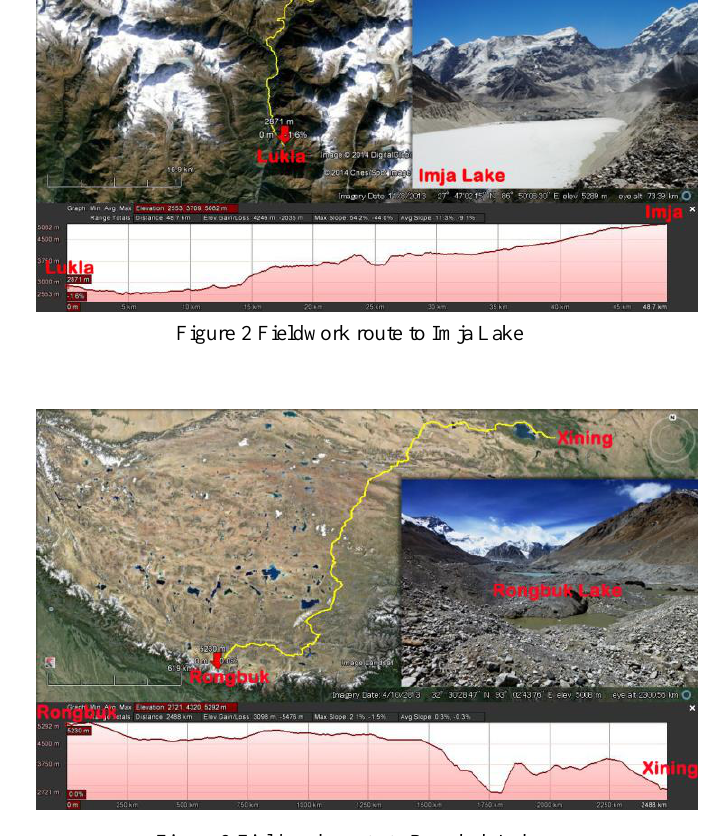
Figure 3 Fieldwork route to Rongbuk